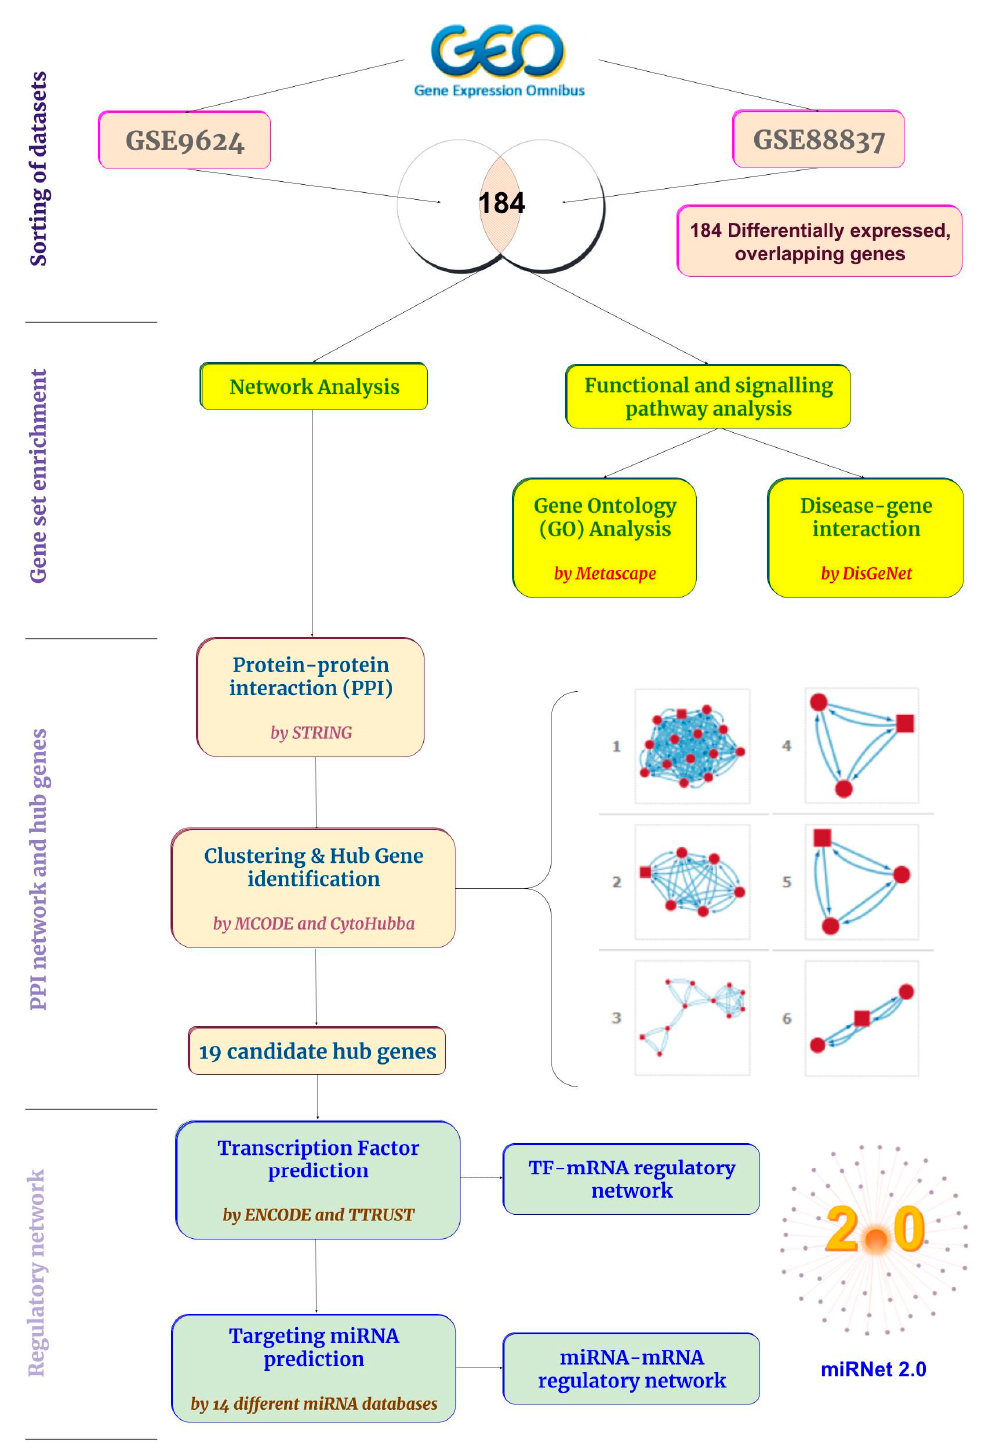
Figure 1. The schematic flow of the study.